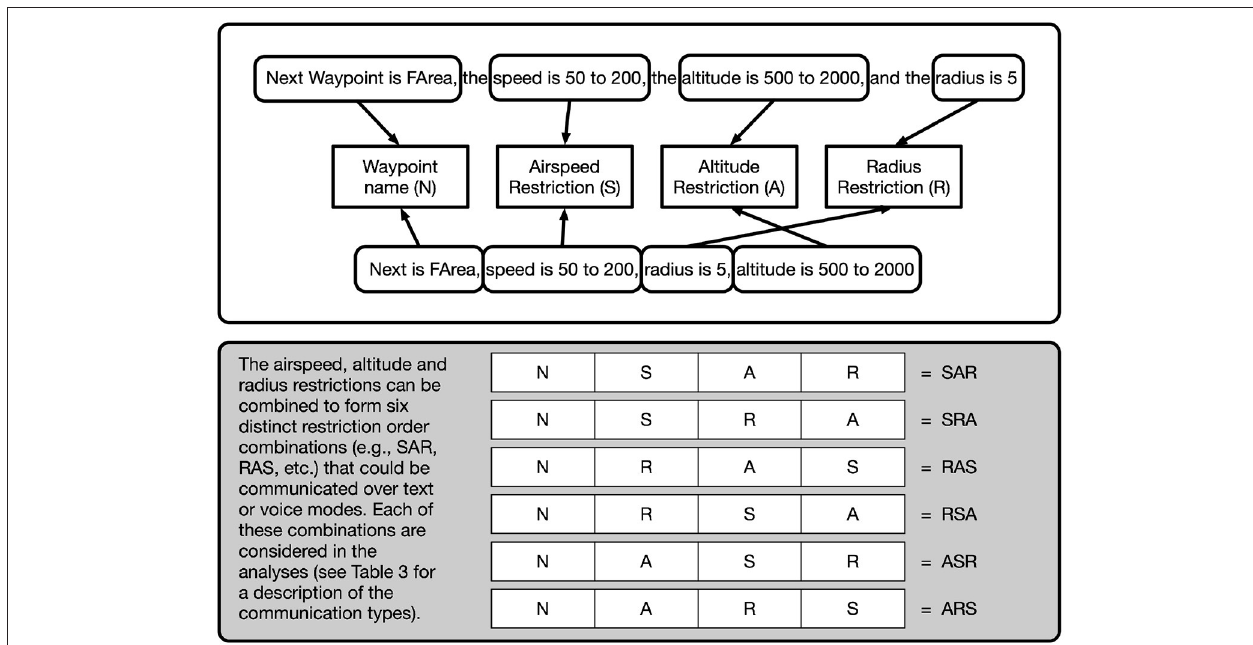
FIGURE 1 | Deconstructing and identifying communications as an ordered set of waypoint restrictions: airspeed, altitude, and radius. In the top white box, example communications (text or speech) where aspects of a communication are tagged as being either a waypoint name, airspeed restriction, altitude restriction, or radius. The communications are deconstructed and tagged based on their restriction order (e.g., RSA, ARS, etc.; bottom gray box) for further